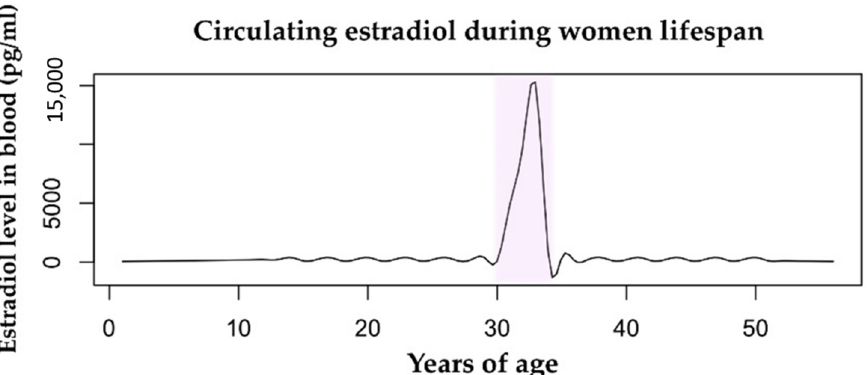
Figure 1. Estradiol levels in the bloodstream vary throughout a woman’s lifespan. The mean value during childhood is 200 pg / mL. During fertility age, the menstrual cycle range is 100–400 pg / mL. The pregnancy condition (highlighted in pink) is characterized by a huge increase in levels of circulating estradiol from the first trimester to delivery, with a range of 2000–15,000 pg / mL. During menopause, the level of estrogens drops drastically to < 100 pg / mL. Data retrieved from Watson et al., 2010 [36]. Estrogen Receptors